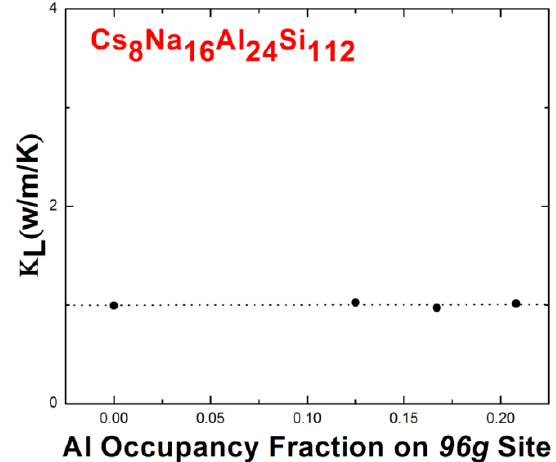
Figure 6. The predicted lattice thermal conductivity as a function of Al occupancy on the 96 g Wyckoff site. The dotted line is used for comparison.